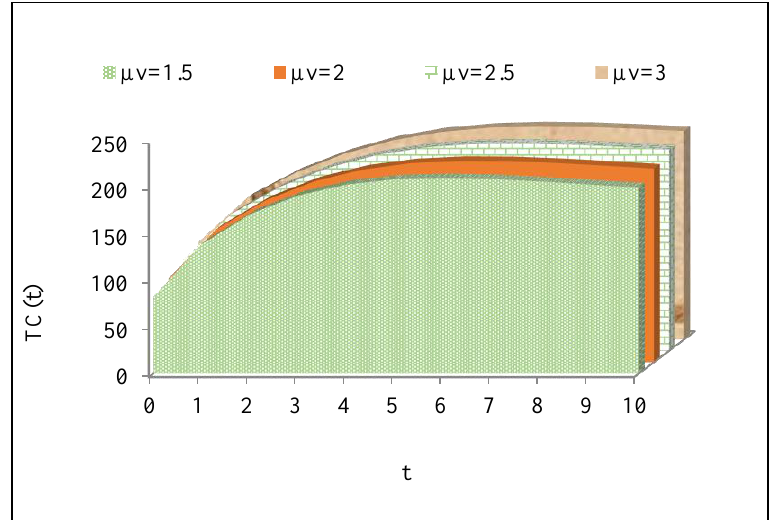
Figure 5. TC(t) vs t at various values of